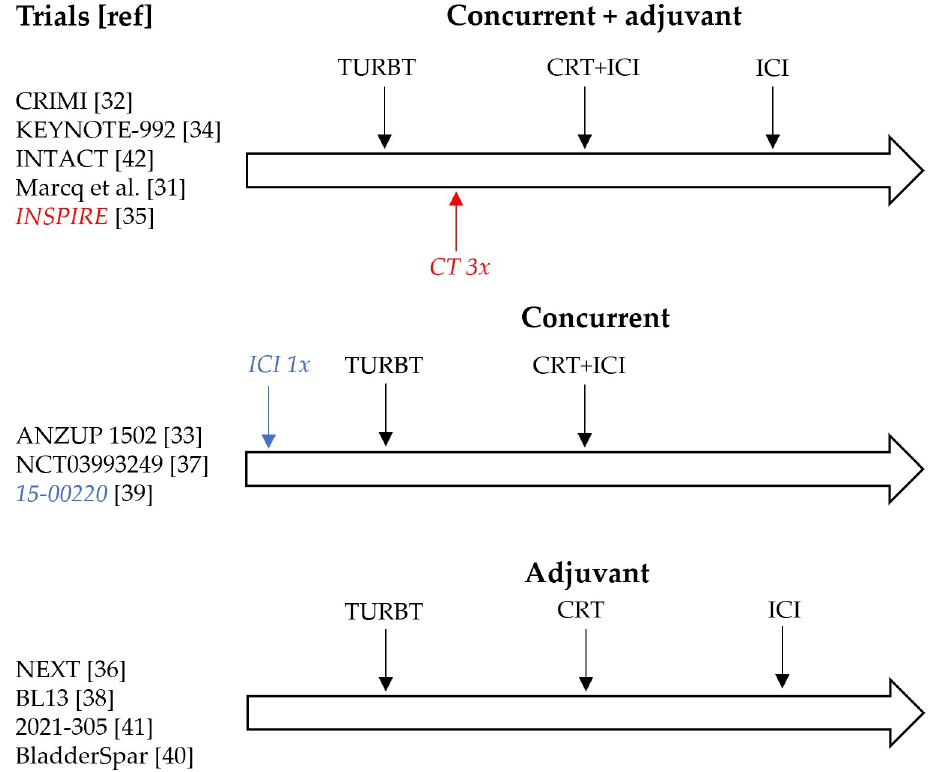
Figure 2. Overview of different CRT + ICI schedules under investigation.